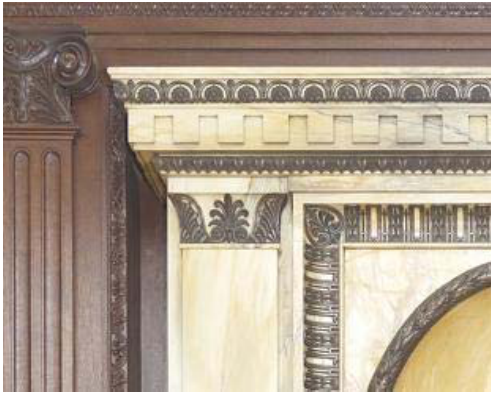
Picture 5: Detail of picture at a scale of 1:20